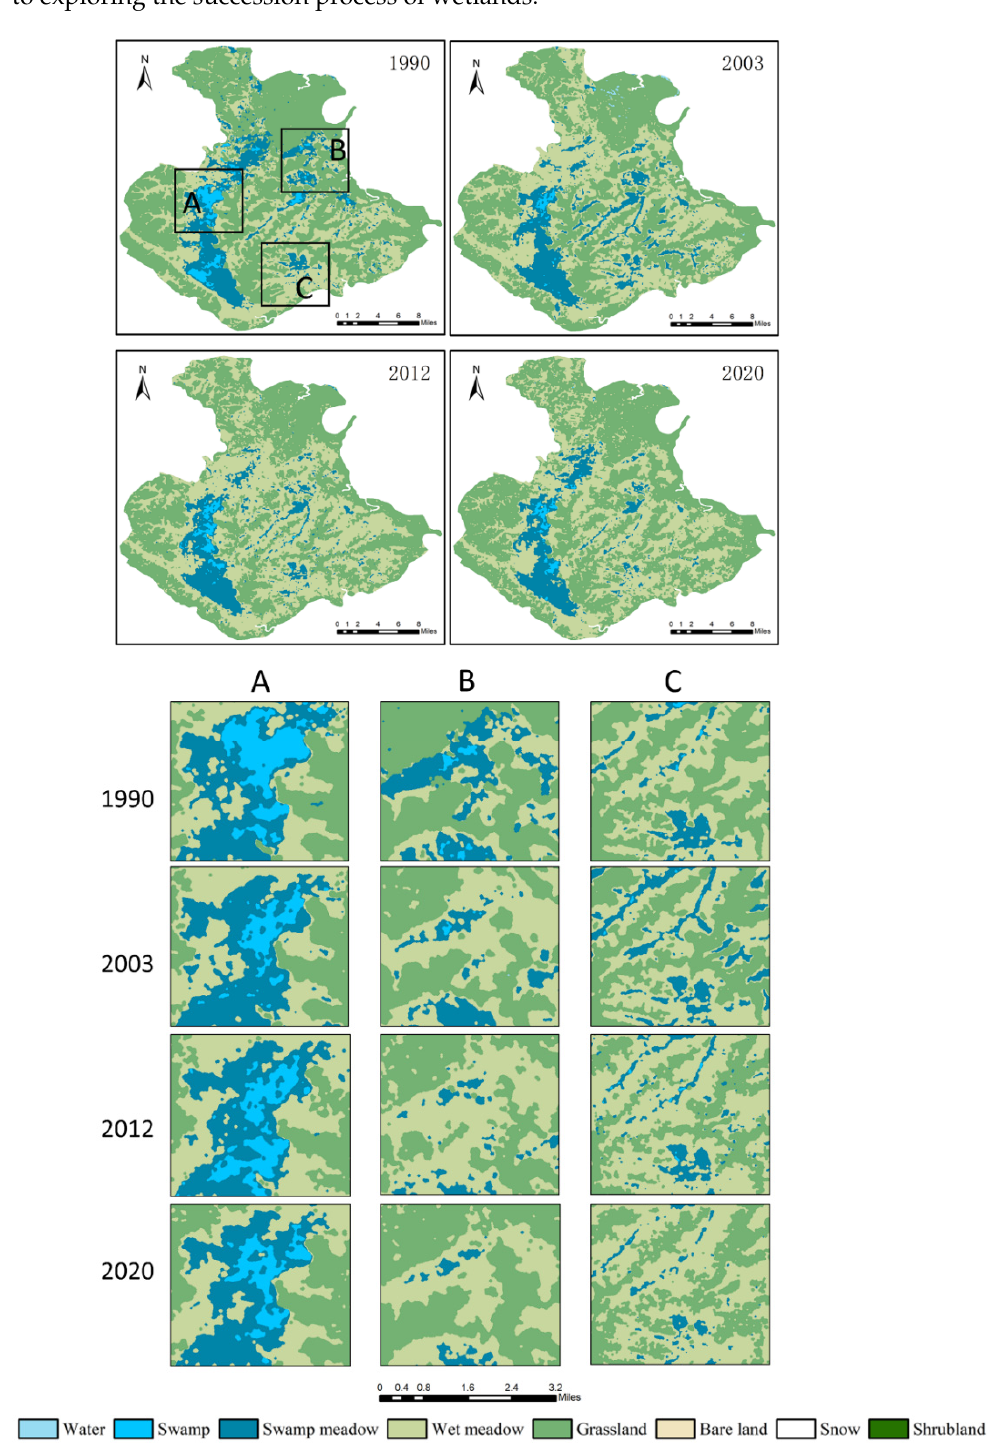
Figure 13. Distribution and local enlarged details of wetlands in the four periods ( A , B , C ) represents three different local enlarged details of wetlands in 1990, 2003, 2012 and 2020). three different local enlarged details of wetlands in 1990, 2003, 2012 and